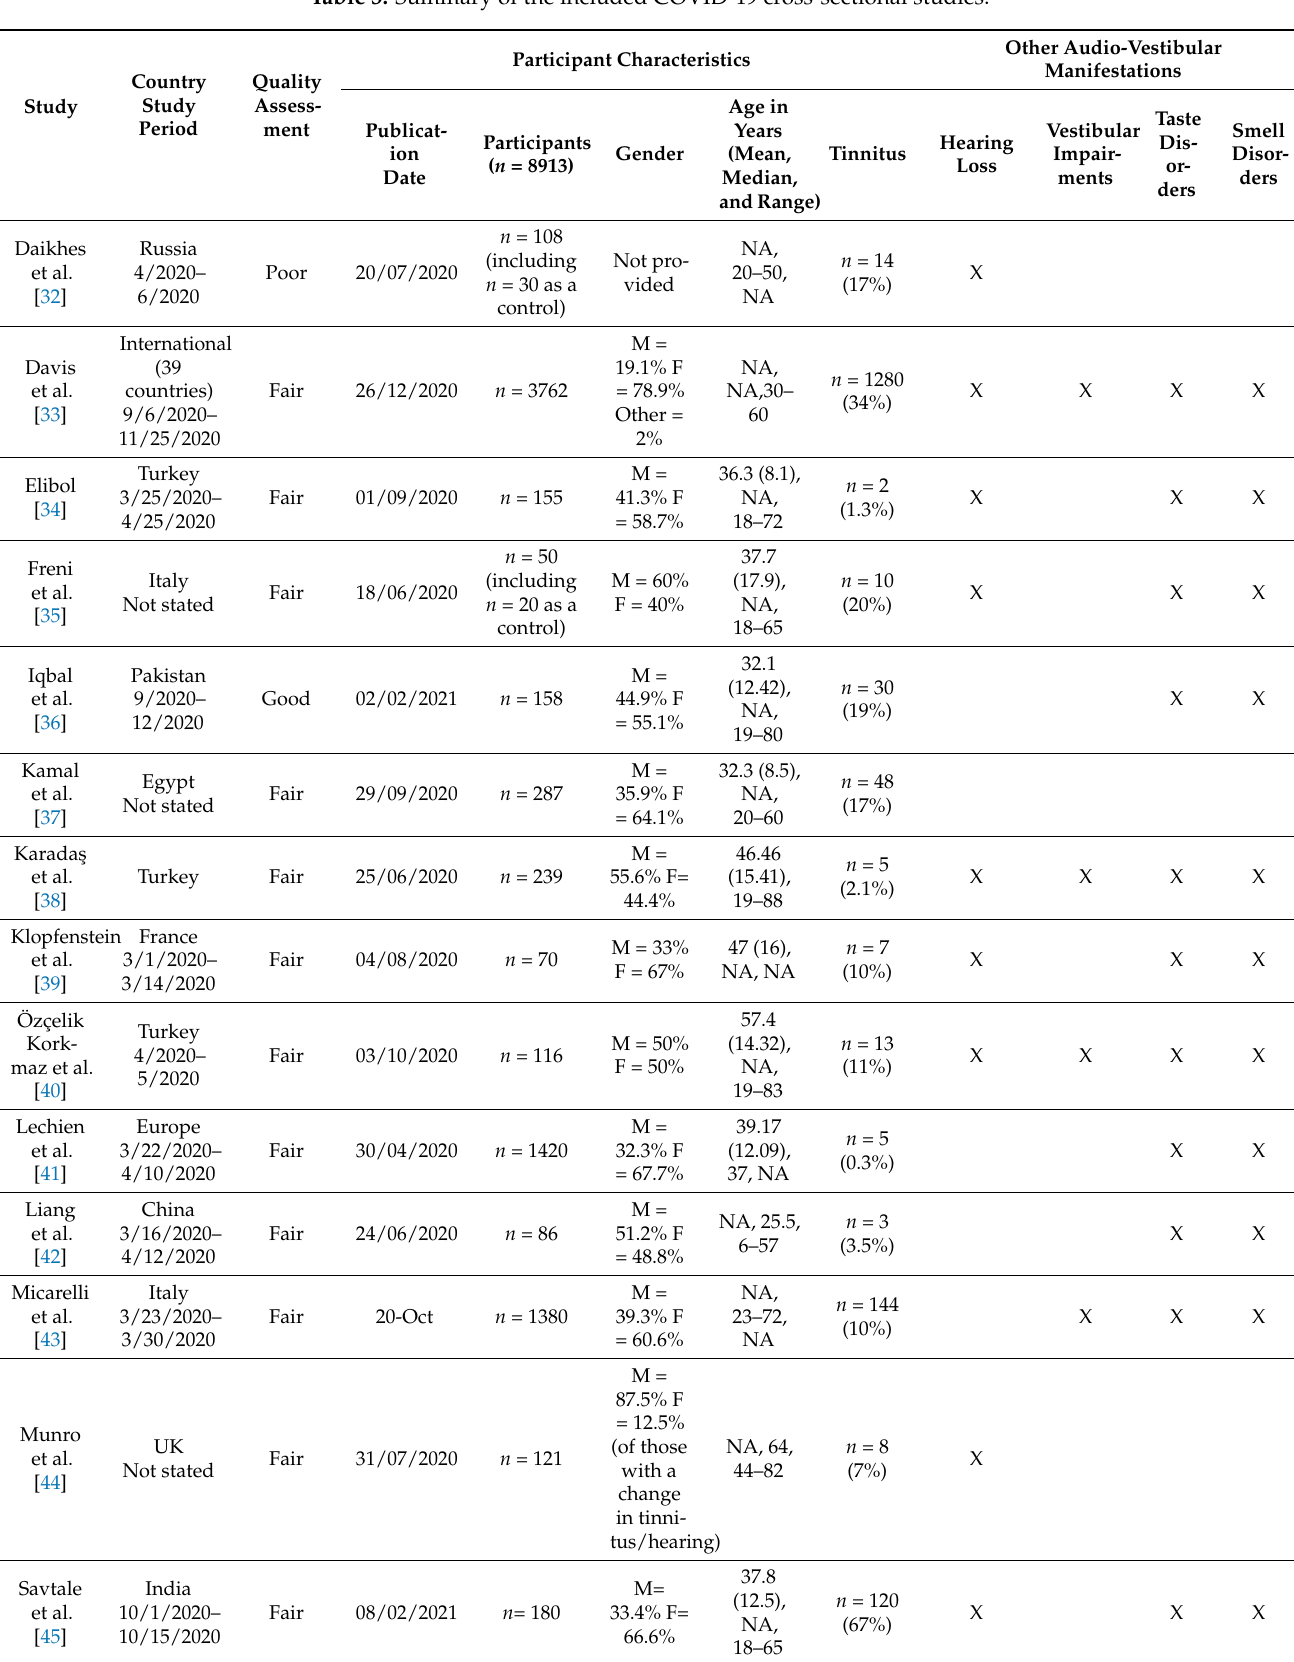
Table 3. Summary of the included COVID-19 cross-sectional